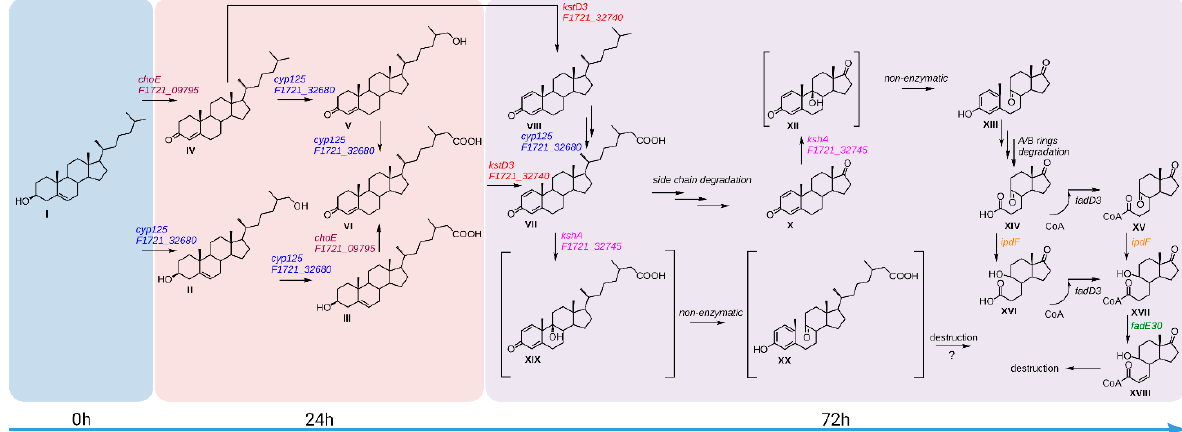
Figure 9. A scheme of the proposed involvement of the five genes of interest in cholesterol biocon- version by S. hirsuta . I, cholesterol; II, cholest-5-ene-3 β ,26-diol (26-hydroxycholesterol); III, 3 β -hy- bioconversion by S. hirsuta . I, cholesterol; II, cholest-5-ene-3 β ,26-diol droxy-cholest-5-en-26-oic acid; IV, cholest-4-en-3-one; V, 26-hydroxy-cholest-4-en-3-one; VI, 3-oxo- cholest-4-en-26-oic acid; VII, 3-oxo-cholesta-1,4-dien-26-oic acid; VIII, cholesta-1,4-dien-3-one; X, an- drosta-1,4-diene-3,17-dione (ADD); XII, 9 α -hydroxyandrosta-1,4-diene-3,17-dione (unsTable 9 α -hy- droxy-ADD); XIII, 3 β -hydroxy-9,10-seco-androsta-1,3,5(10)-triene-9,17-dione (3-HSA); XIV, 9,17-di- oxo-1,2,3,4,10,19-hexanorandrostan-5-oic acid (DOHNAA) or 3a α -H-4 α -(3 ′ -propanoate)-7a β -